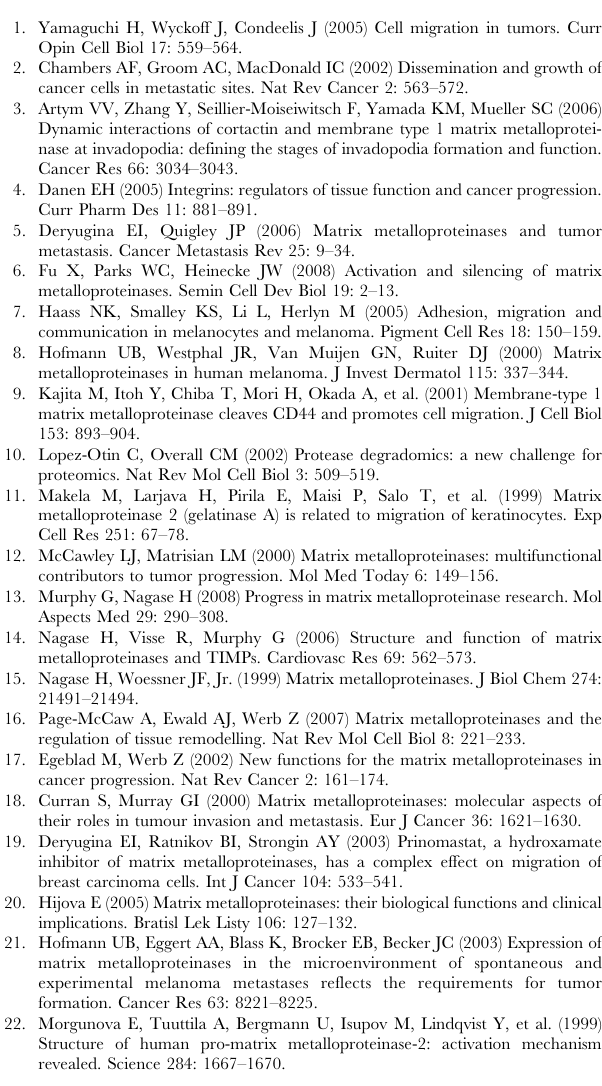
Figure S3 The effect of MMP-2 activity on the adhesion and migration of human DU145 prostatic cancer cells. (A) The effects of GM6001 on DU145 cell adhesion were analyzed in different concentration regarding its function on the different MMP individuals as described in MATERIALS AND METH- ODS. (B) DU145 cells were fluorescently stained and seeded on 48-well plates coated with 10 m g/ml human fibronectin (FN) or BSA as control. The cells were treated using RGD peptides or MMP-2I. The fluorescence intensity was measured using a fluo- rescence spetrophotometer. Statistical difference were determined by comparing treated group with the normal control by t-test (**, P , 0.005). (C) The photomicrographs of DU145 cells in the agarose drop model 48 h after seeding. The arrows point the